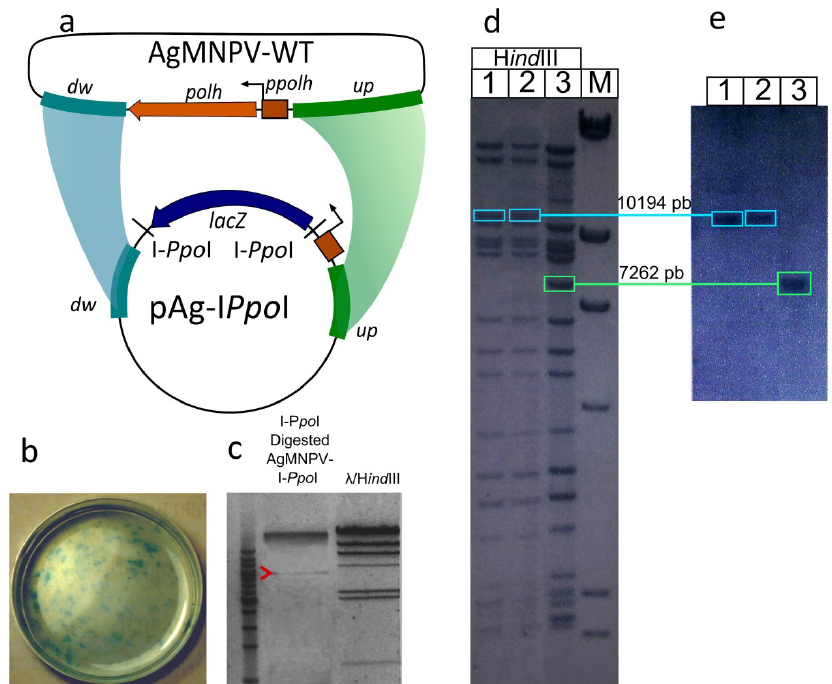
Figure 1. Generation of the parental genome AgMNPV-I -Ppo I. ( a ) Homologous recombination between AgMNPV-2D and pAgI Ppo I substitutes the lacZ ORF for the polyhedrin ORF and provides two I- Ppo I restriction sites. The sequences flanking the polh gene are indicated as up (upstream: 829 bp) and dw (downstream: 883 bp); ( b ) Cell culture dish infected with AgMNPV - I -Ppo I showing lacZ β -galactosidase-positive plaques; ( c ) AgMNPV-I -Ppo I digested with I- Ppo I: release of a 3 kb fragment (see arrowhead) containing the lacZ ORF flanked by I -Ppo I restriction sites; ( d ) Hin dIII restriction patterns of genomic DNA from two AgMNPV-I -Ppo I clones (lanes 1, 2) and wt AgMNPV (lane 3). The Hin dIII G bands are highlighted with boxes; ( e ) Southern blot using a probe targeting downstream polh sequences in band G with (10,194 bp; lanes 1, 2) or without (7262 bp)